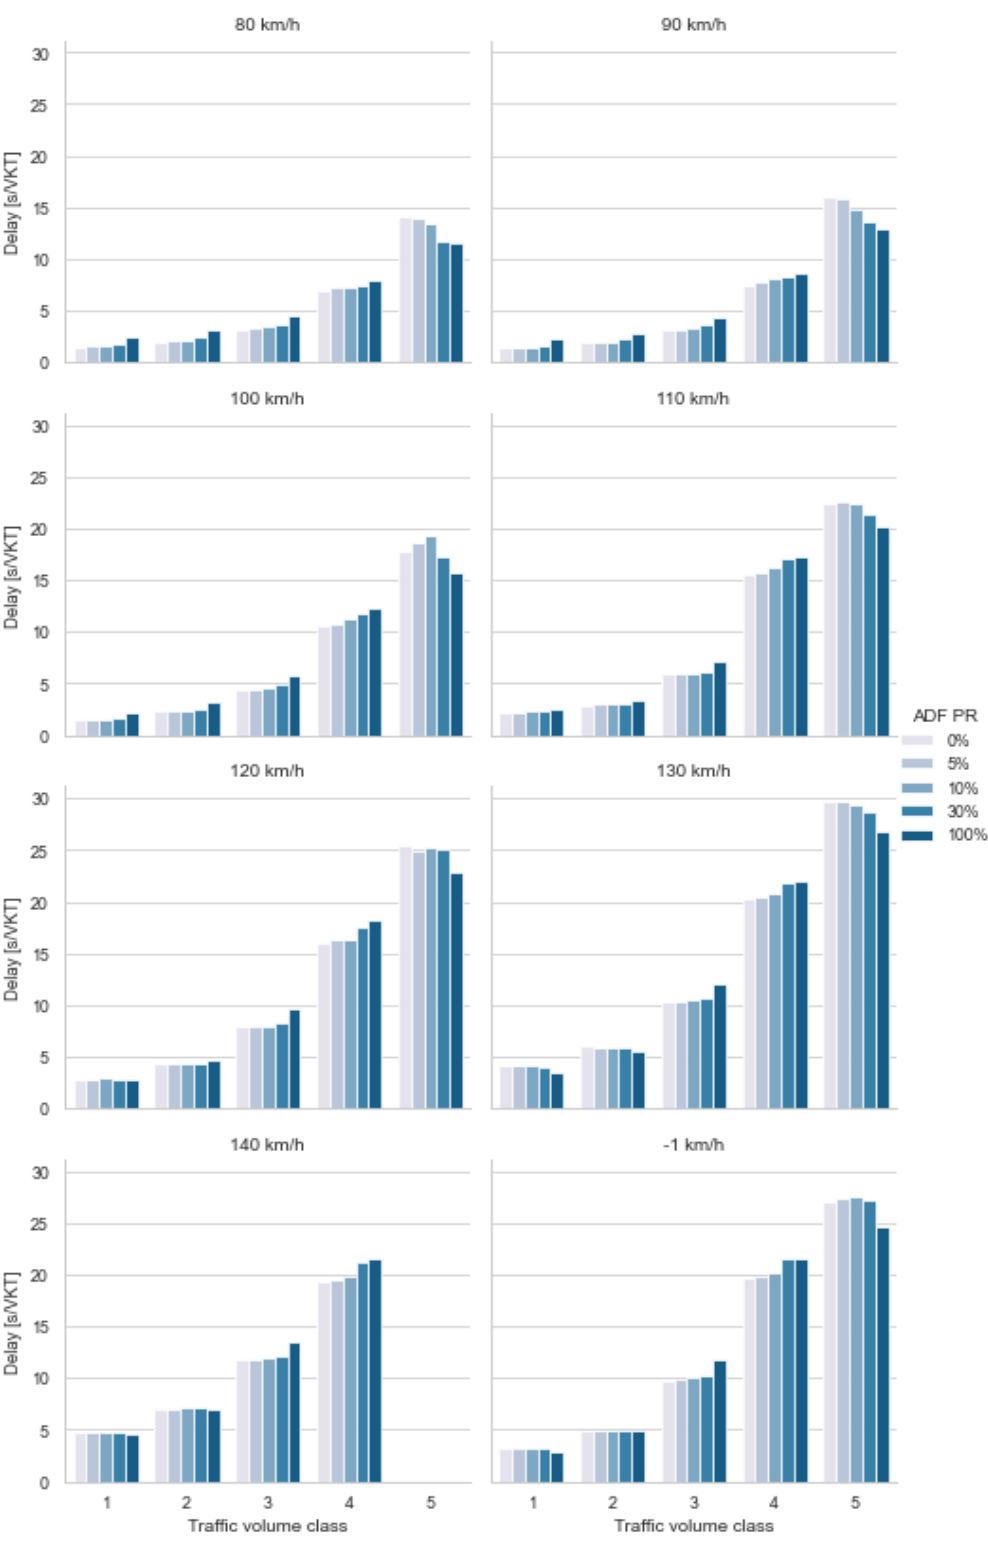
Figure 11. Average delay in seconds per VKT for speed limits 80 to 140 km/h and unlimited (-1 km/h) per traffic volume class and AV penetration rate on EU27+3 motorways. Volume class 1: up to 750 veh/h/lane; 2: 751–1250 veh/h/lane; 3: 1251–1750 veh/h/lane; 4: 1751–2250 veh/h/lane; 5: over 2250